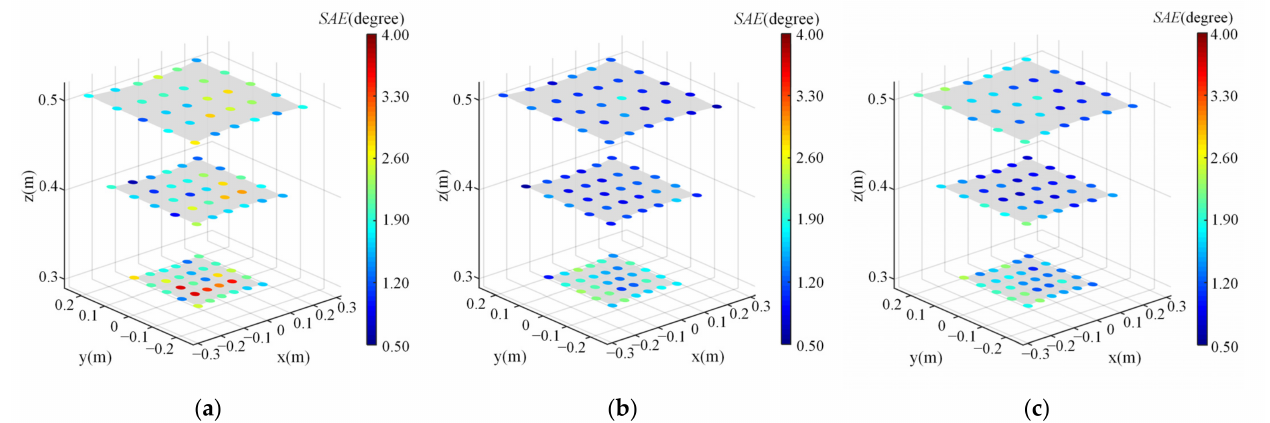
Figure 10. The scene angular error at each of the 90 test points for different methods. Noted that the error of each test point is calculated by averaging the error of the same test point for all subjects. The coordinates of these test points are represented in union eyeball coordinate system. ( a ) Nonlinear optimization. ( b ) Primary calibration method. ( c ) Recalibration